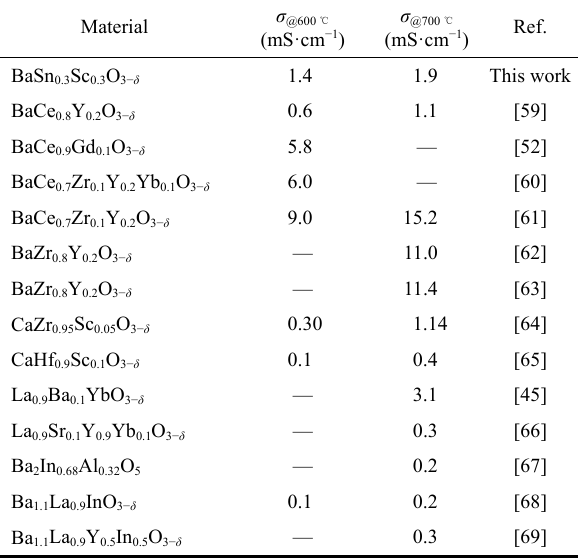
Table 2 Ionic (predominantly protonic) σ of proton- conducting materials determined within the electrolytic domain boundary region of the log σ –log p (O 2 ) dependences